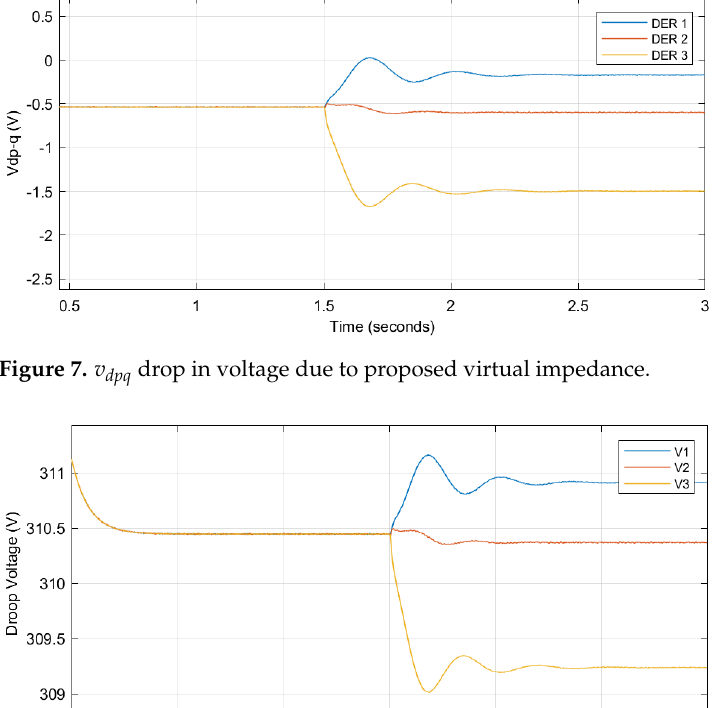
10 of 17 Figure 5. v dpd drop in voltage due to proposed virtual impedance.